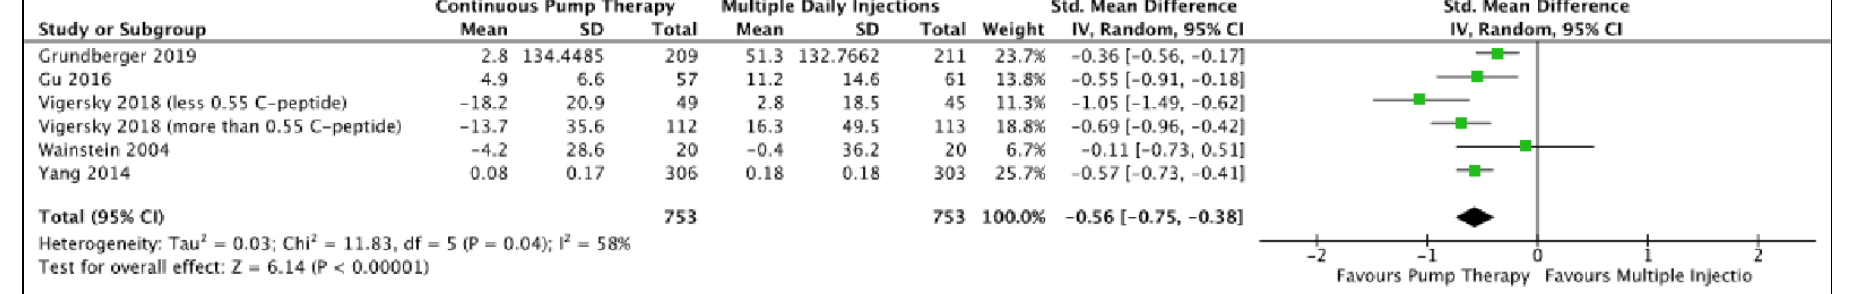
Figure 7. Meta-analysis results and Forest plot for Daily Insulin Dose.